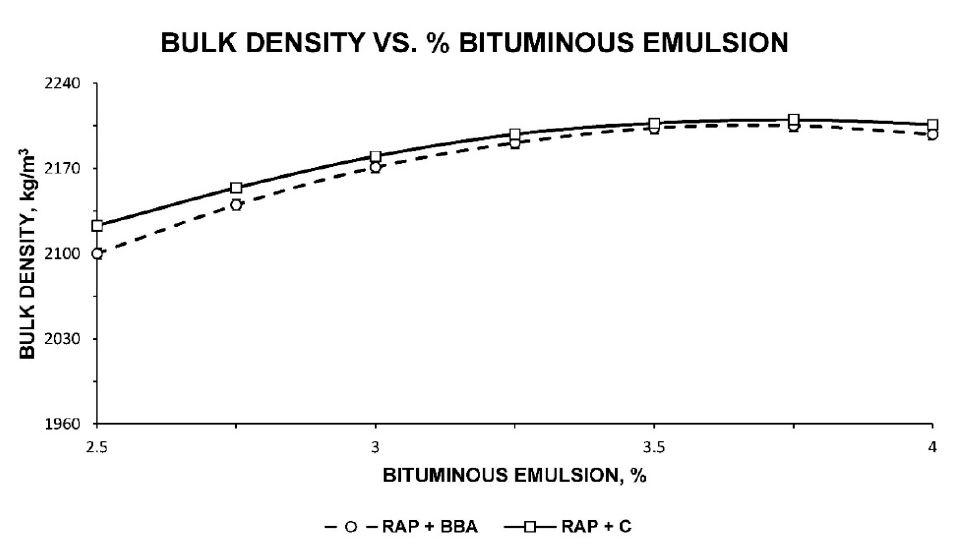
Figure 8. Graph of the results of the bulk density test, standard UNE-EN 12697-6, for bituminous mixtures made with RAP and BBA (RAP + BBA), as well as for bituminous mixtures with RAP and limestone aggregate (RAP + C).